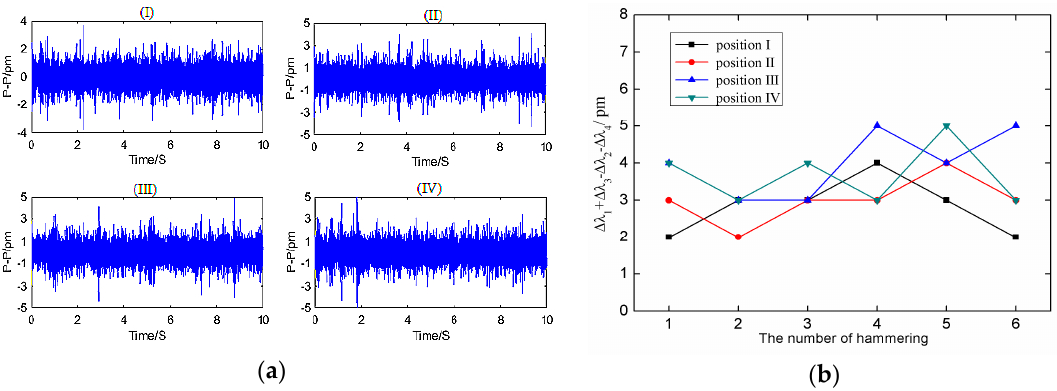
Figure 14. The results of anti-interference characteristic experiments. ( a ) Time-domain plots of Δ λ 1 + Δ λ 3 − Δ λ 2 − Δ λ 4 at four different hammering locations. ( b ) The results of Δ λ Δ λ 3 − Δ λ 2 − Δ λ 4 at different percussion positions under multiple beats.